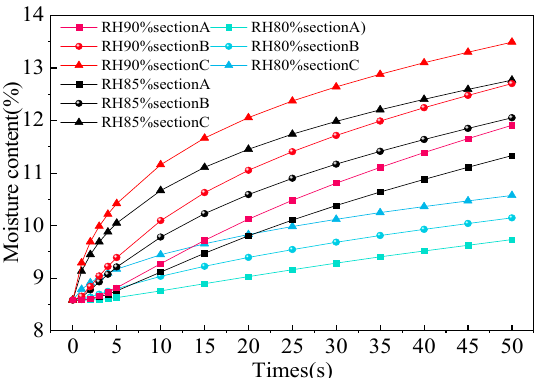
Figure 7. The moisture content changes of heaped tobacco strips.